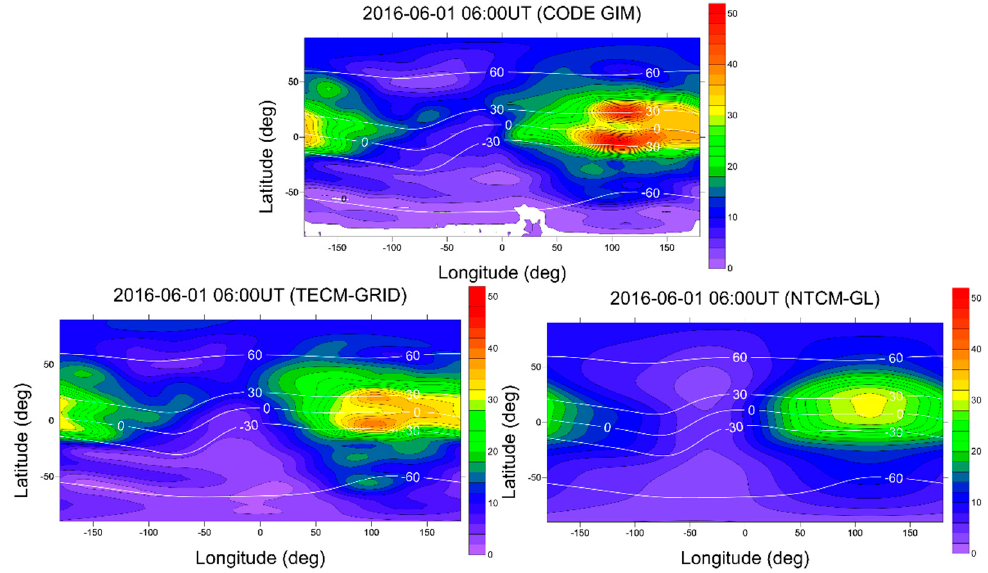
Figure 10. Comparison of TECM-GRID and NTCM-GL with the CODE GIM (1 June 2016).